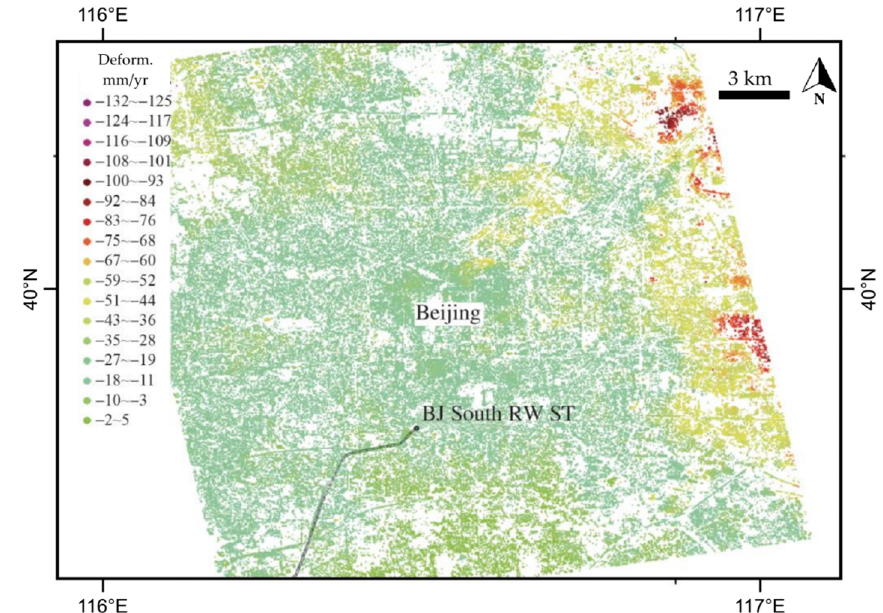
Figure 7. GF-3 SBAS subsidence map of Beijing.